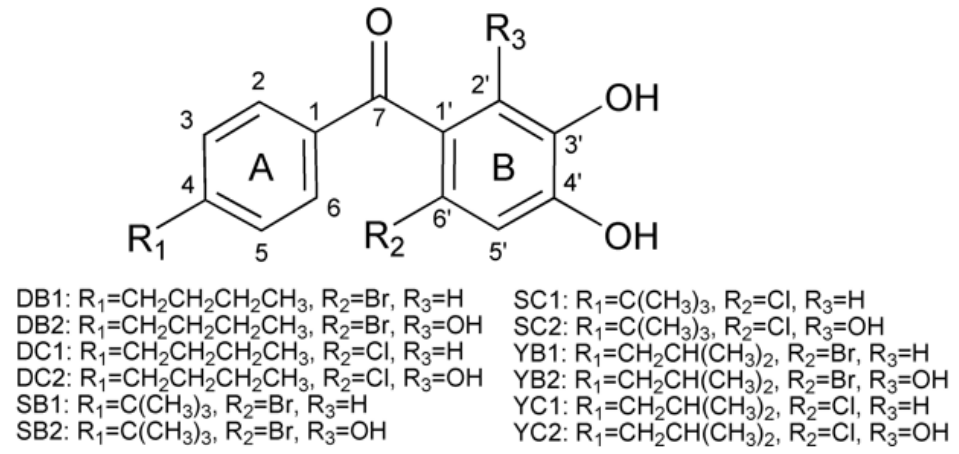
Figure 1. Structures of twelve polyhydroxy benzophenone